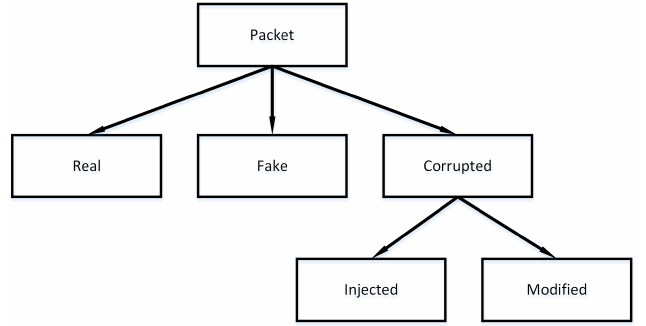
Figure 2. Packet